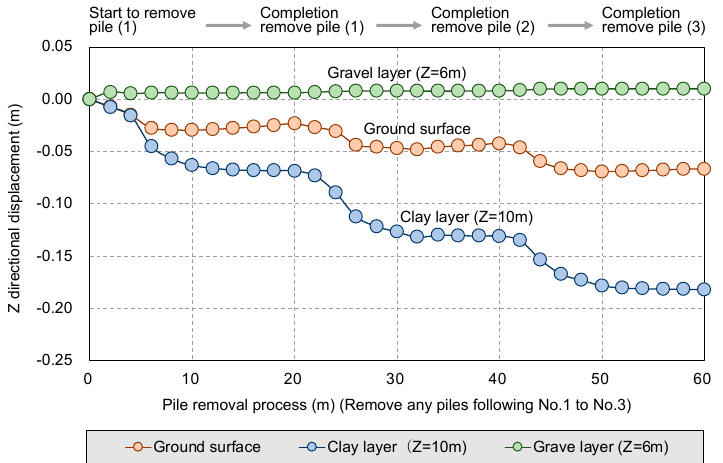
Figure 12. Subsidence of the surrounding ground in the process of forming three extraction holes of removed piles.